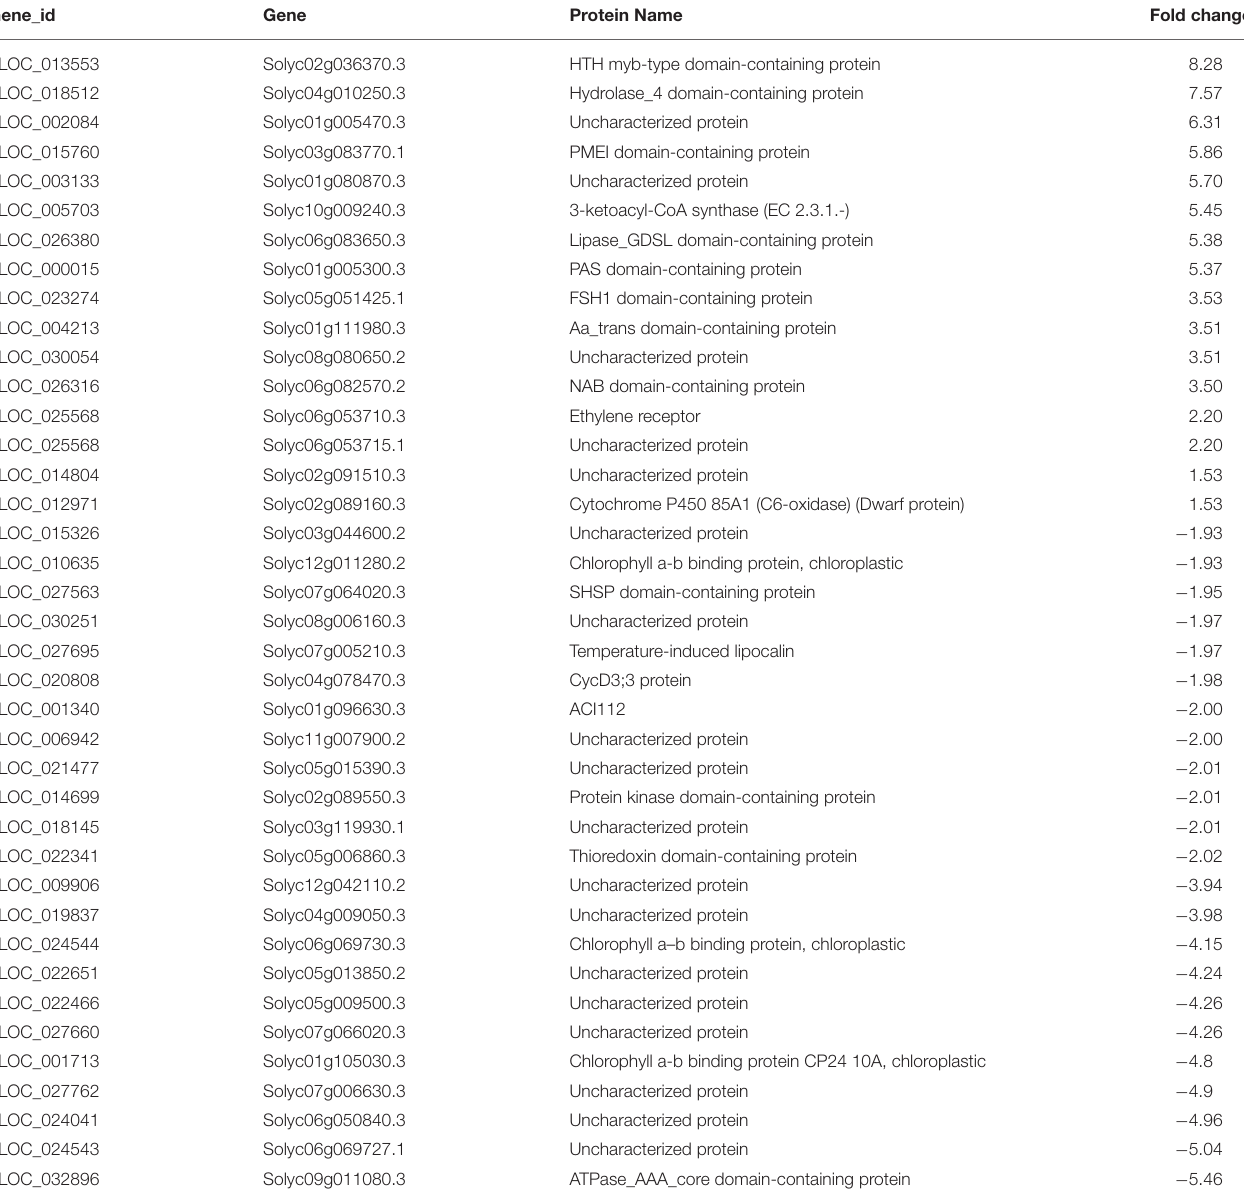
TABLE 2 | The gene IDs, protein names, and fold change of DEGs in tomato plants treated with Cg-2 are represented in the heat map. Gene_id Gene Protein